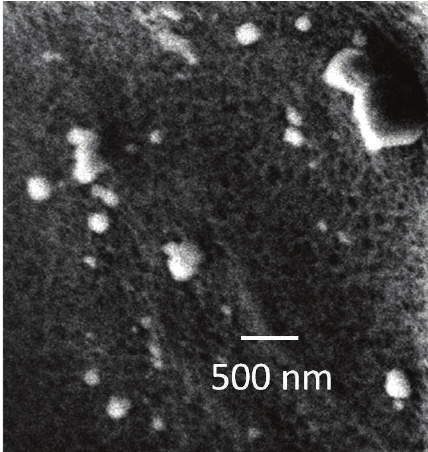
Figure3:Heliumionmicroscopeimageofthenativeagargelloaded with Ag